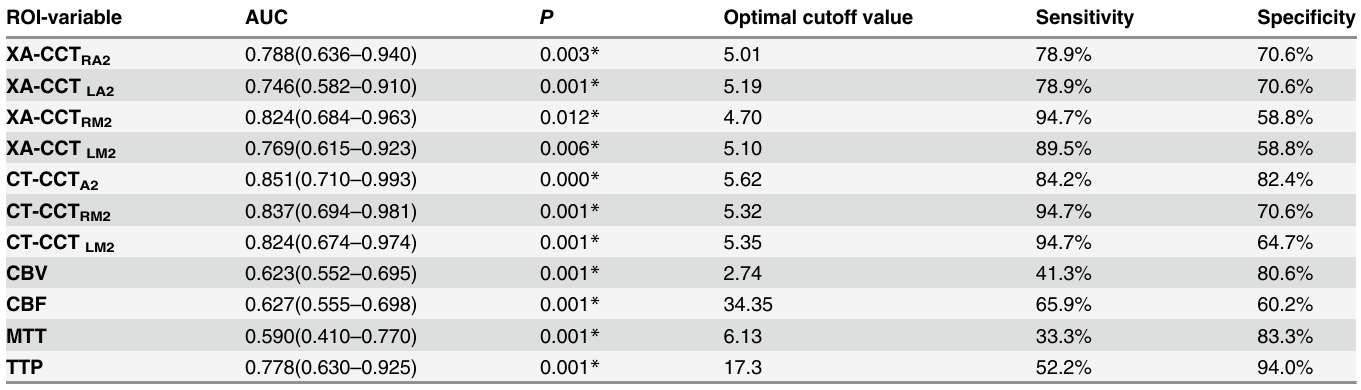
Table 4. Optimal Cutoff Values of Ten all CCT, MTT, and TTP for Predicting Vasospasm.